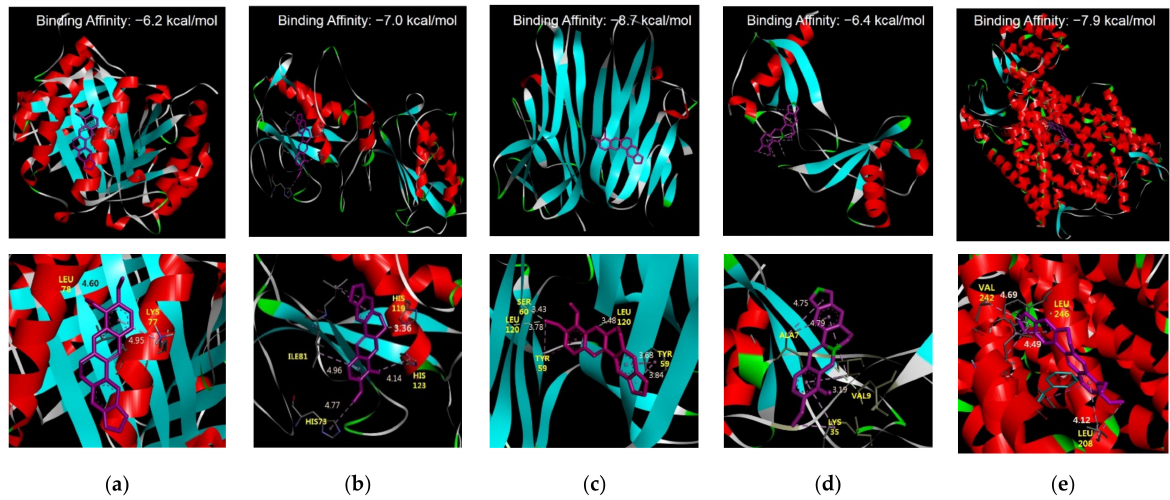
Figure 2. Molecular docking simulation. ( a ) BBR and M1 macrophage; ( b ) BBR and M2 macrophage; ( c ) BBR and TNF; ( d ) BBR and CCL2; ( e ) BBR and CXCR4. M1 macrophage (PDB ID: 1GD0), M2 macrophage (PDB ID: 1JIZ), TNF- α (PDB ID: 2AZ5), CCL2 (PDB ID: 1DOK) and CXCR4 (PDB ID: 3ODU). Binding energy values are written on the top of each subfigure. BBR: berberine, TNF: tumor